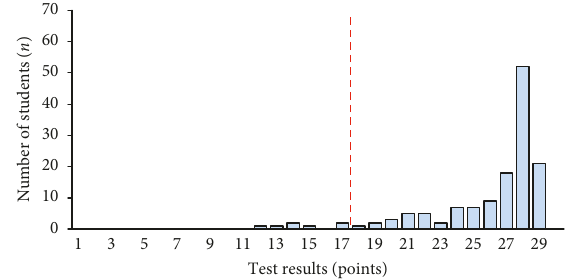
Figure 5: Distribution of points in the obligatory test of the pretest group (cohort 2). 3rd year medical students had to answer ques- tions in pharmacology after a semester course of pharmacology ( n � 142). The dotted line marks the passing grade of 60%. Students which did not attend the voluntary but the obligatory test are